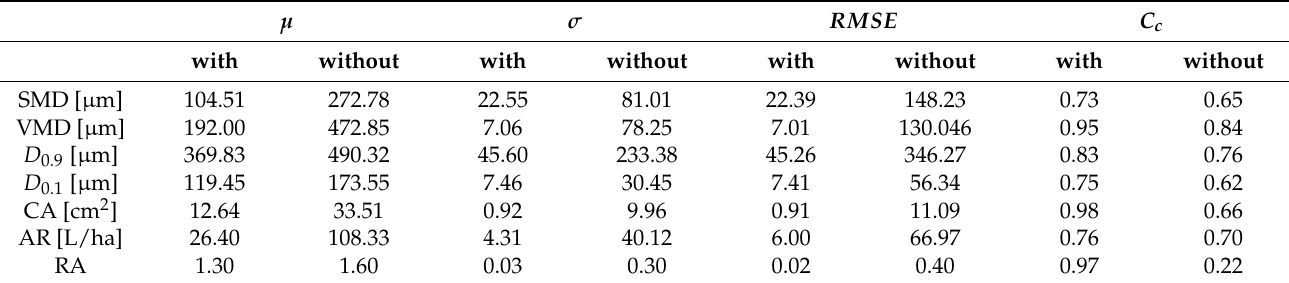
Table 4. The statistical results of the PPQD soft-sensor prediction with and without a interpolation model.